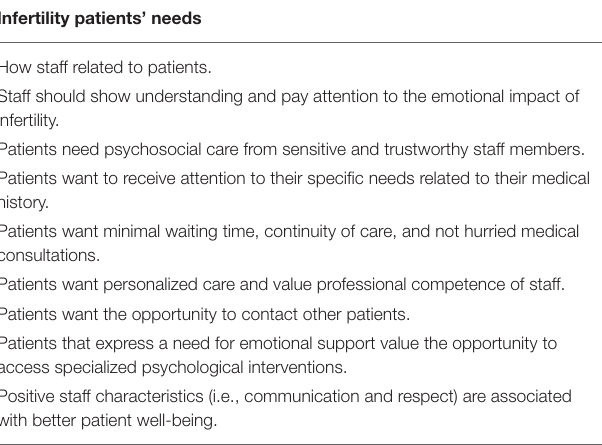
TABLE 2 | What fertility staff should be aware of about patients’ needs. Infertility patients’ needs How staff related to